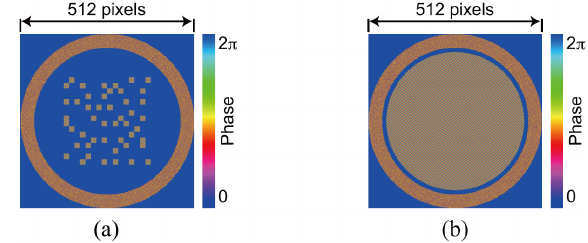
Figure 5. Superimposed phase holograms for ( a ) recording and ( b ) retrieving the data page 1.